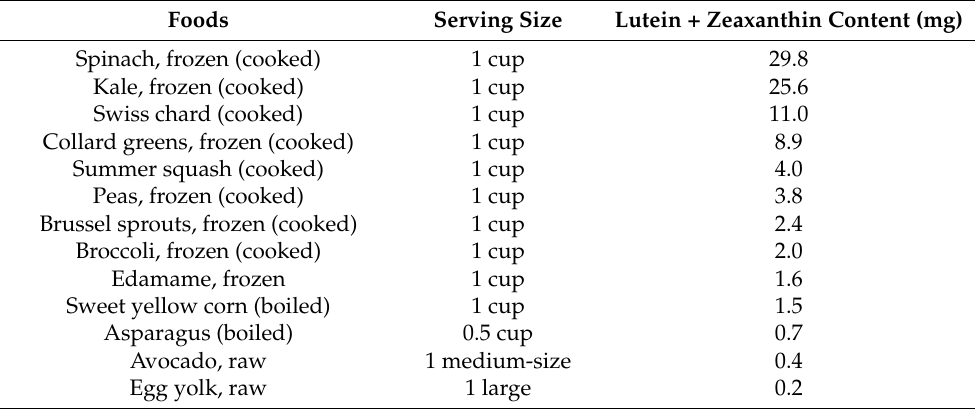
Table 5. Common dietary sources of xanthophylls lutein and zeaxanthin